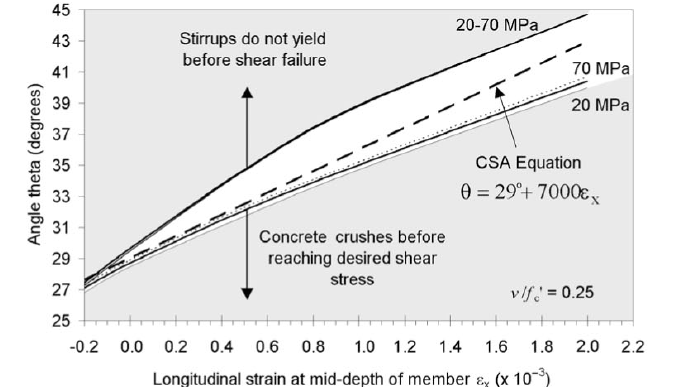
Figure 13: Inclination of the compression field as a function of longitudinal deformation